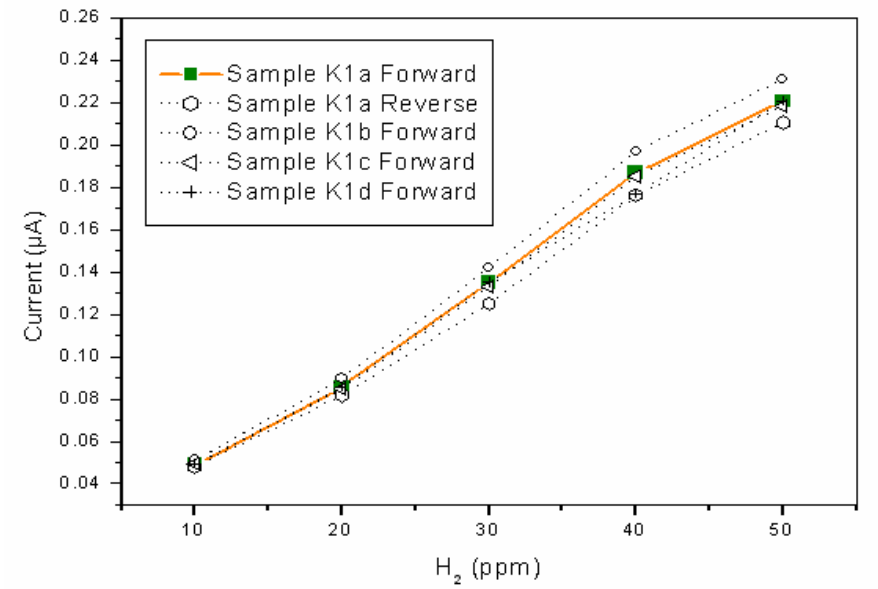
Figure 11. Linear relation for 0.01 M KBH (sample K1) concentration over a low level of hydrogen 4 concentration (10-50 ppm) and a sensing area of 2 cm 2 . The dotted lines are results from calibrations with different